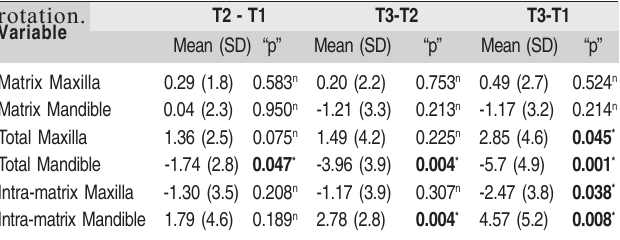
Table 6 . Maxillary and mandibular rotation.